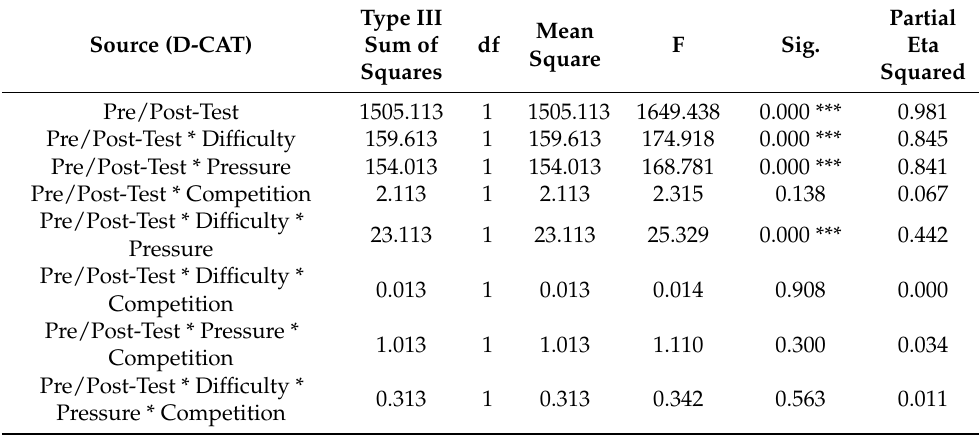
Table 6. Tests of within-subject effects of D-CAT.